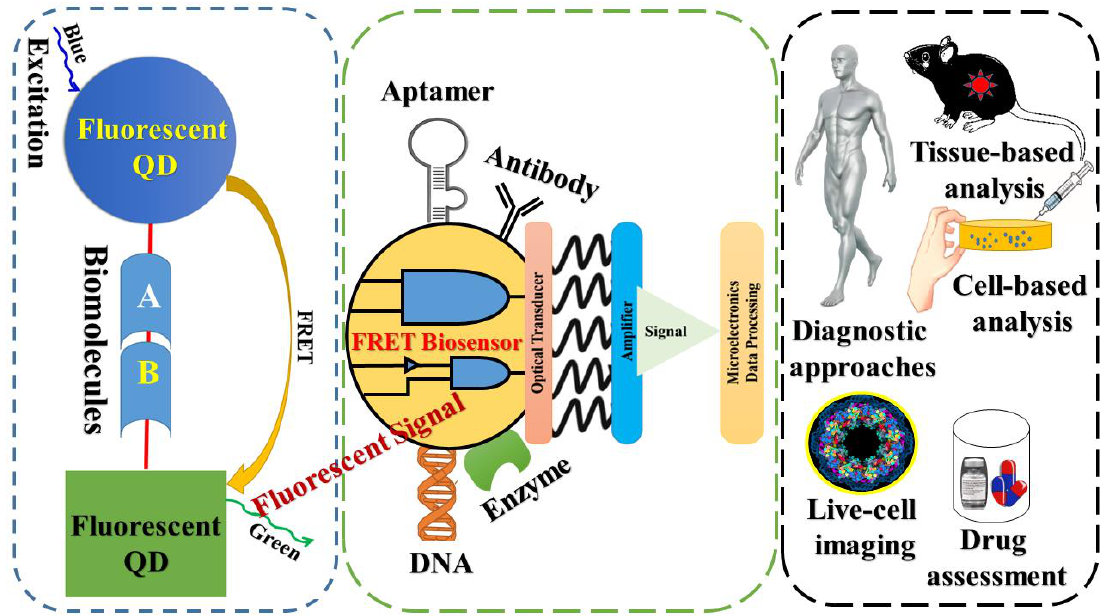
Figure 6. Schematic of designing and working of FRET